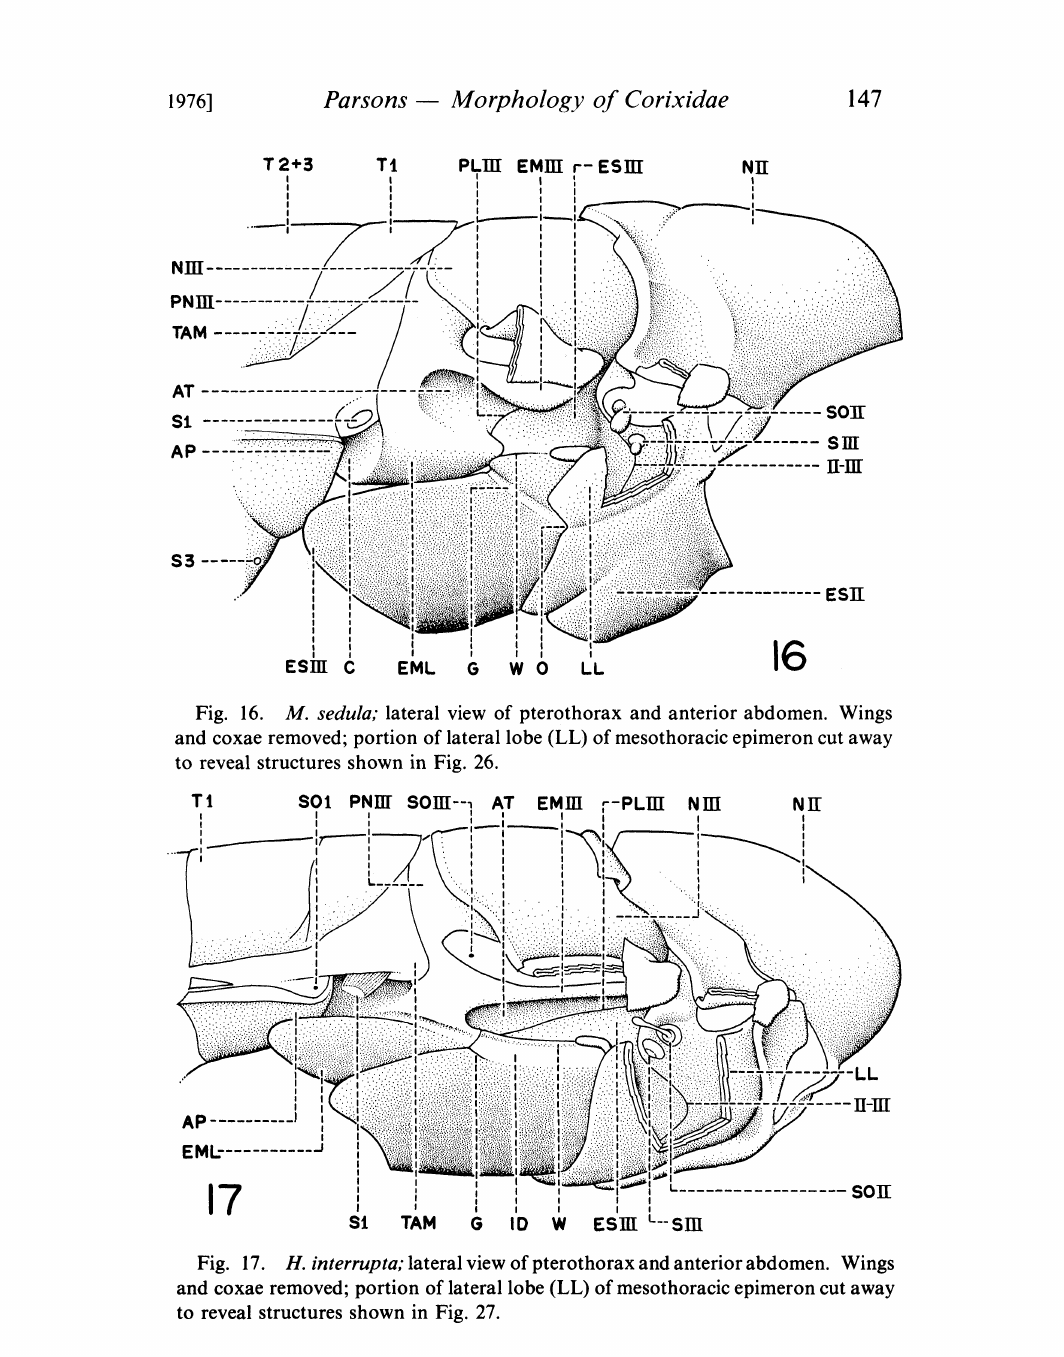
Fig. 17. H. interrupta; lateral view of pterothorax and anterior abdomen. Wings and coxae removed; portion of lateral lobe (LL) of mesothoracic epimeron cut away to reveal structures shown in Fig.